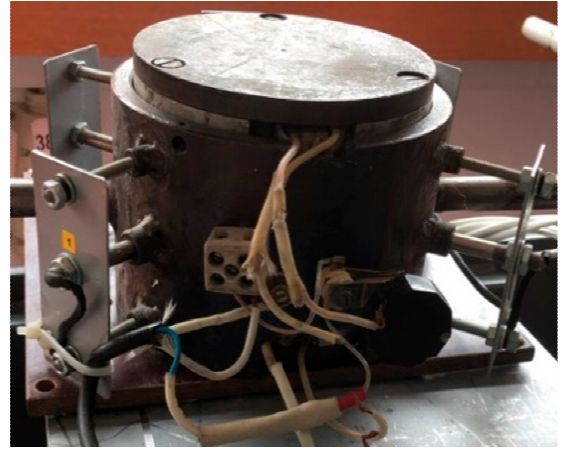
Figure 2. The mold used to obtain material samples by hot pressing [30].